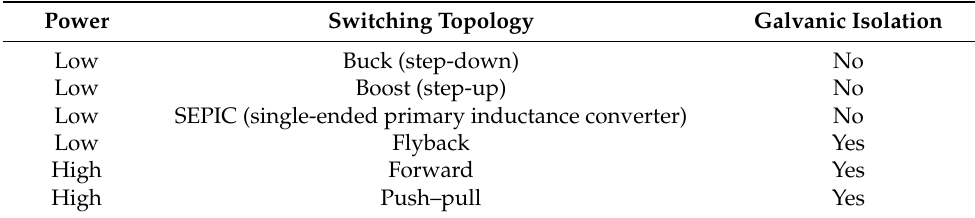
Table 2. Basic architectures for